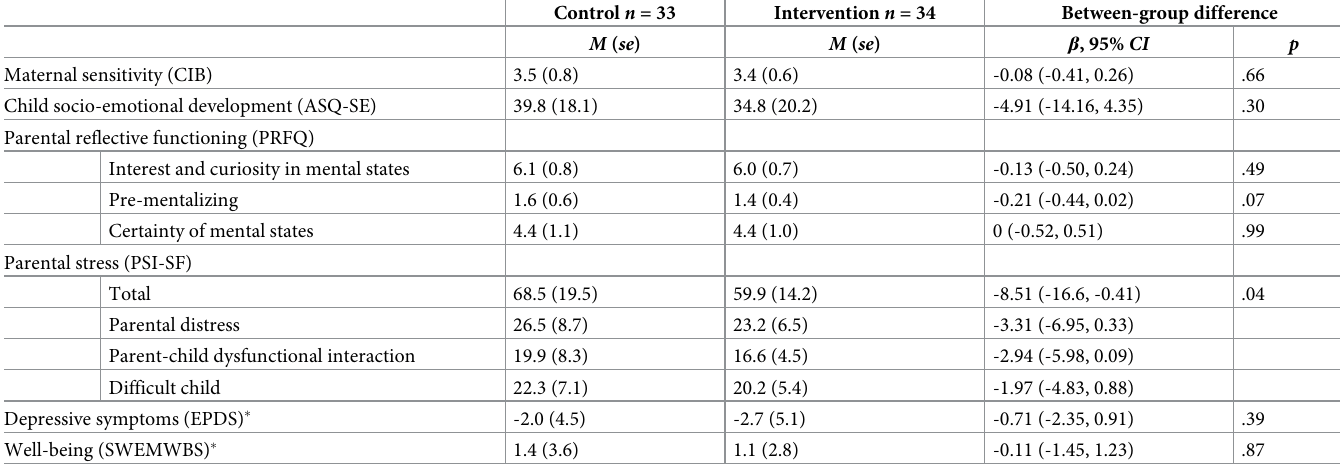
Table 3. Regression coefficients from ANOVA and ANCOVA for association of the COS-P intervention on primary and secondary outcomes at infant age nine